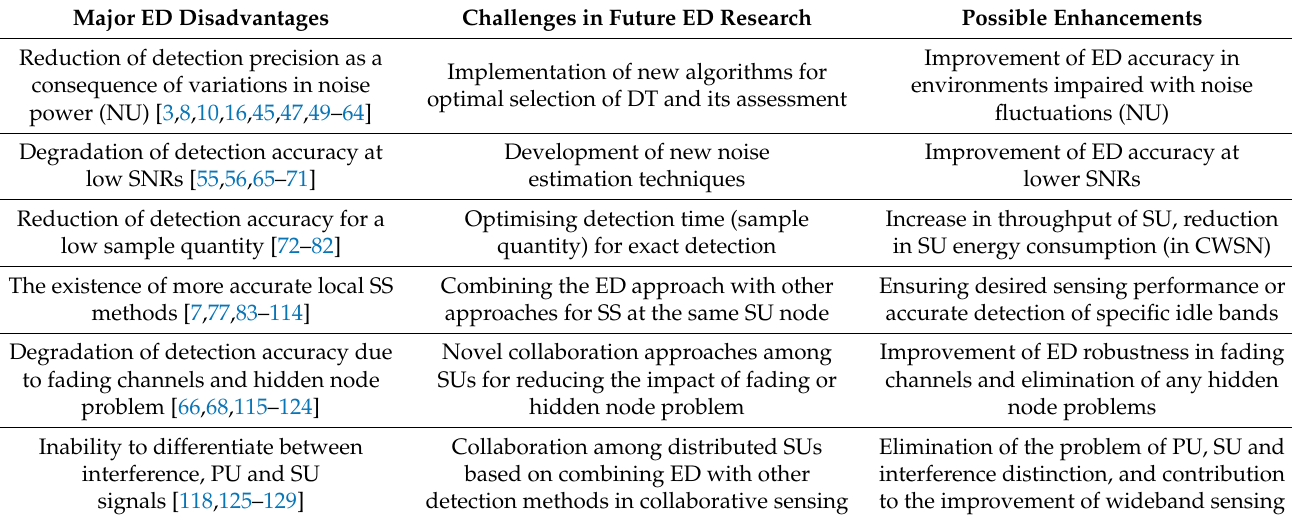
Table 4. Comparison of main ED drawbacks and expected